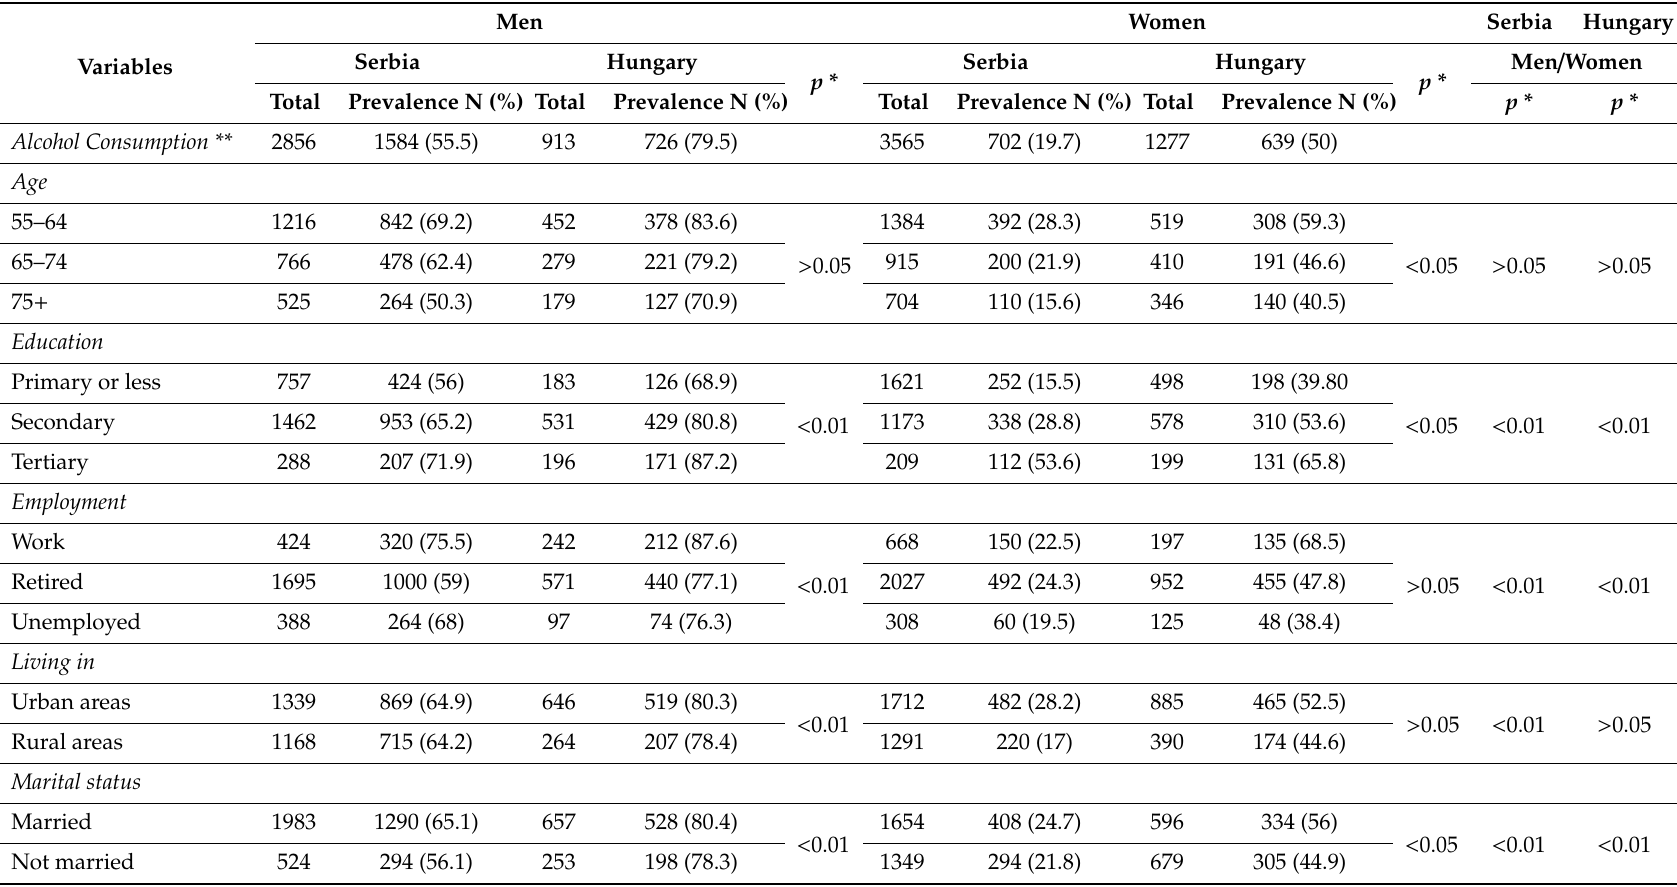
Table 1. The prevalence of alcohol consumption among older adults in Serbia and